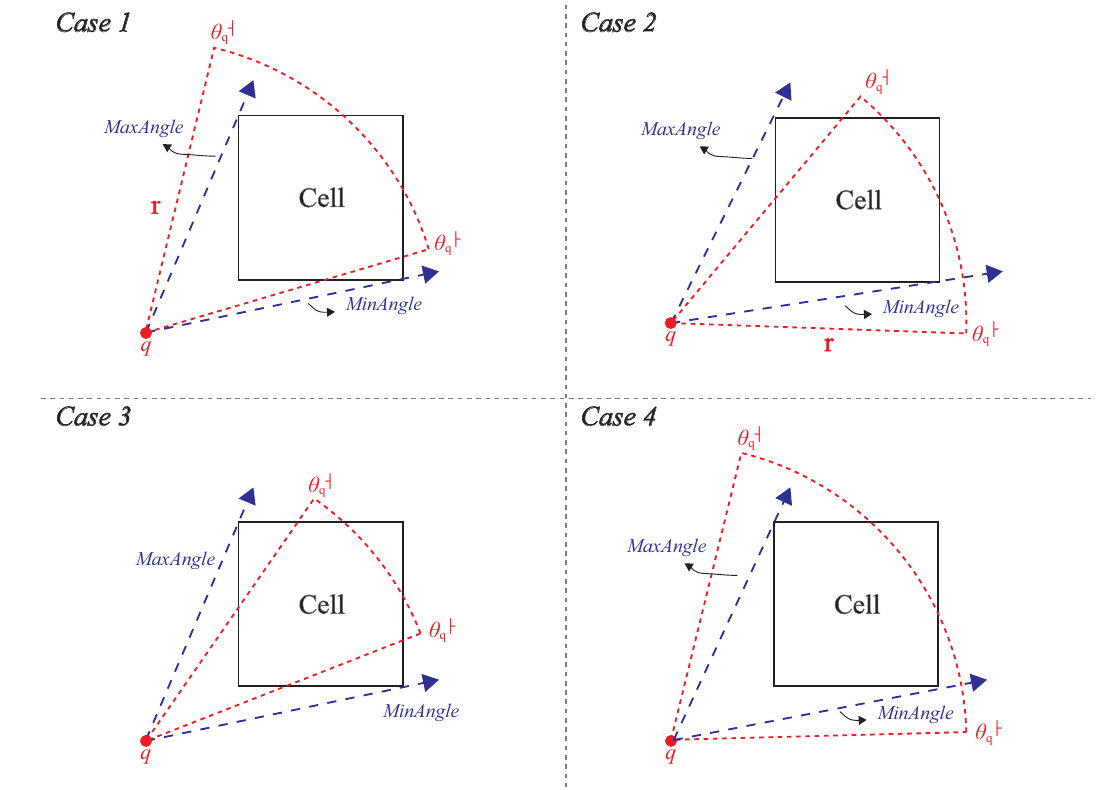
Figure 13. Relationships between a query view field and a